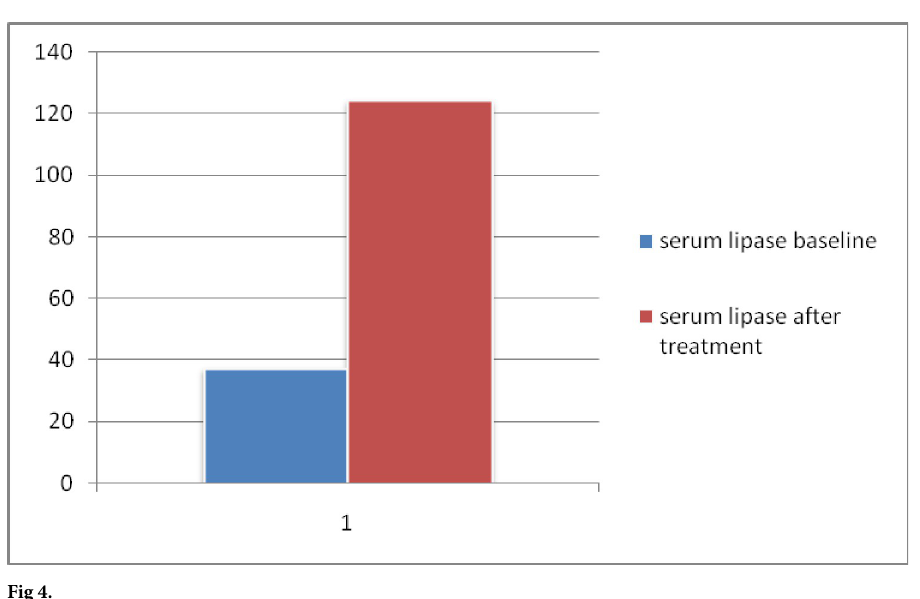
Fig 4. might be there were no exclusion criteria in which a factor that induce acute pancreatitis to that particular studies and due to different age group. However, our study excludes the factors that induces acute pancreatitis. A paired or dependent t-test was done and it showed a statisti- cally significant difference among serum pancreatic amylase and lipase before and after treat- ment with a p-value of < 0.001. There fore, serum amylase at TOC was 141.29 ± 39.07 U/L as compared to (51.33 ± 19.48 U/L) base line serum amylase (Fig 2 and Table 2). Similarly, the mean ± SD of serum lipase at TOC and before treatment was 123.9 ± 47.07 U/L and 37.1593 ± 20.81 U/L respectively. Thus, there was a statistically high significant elevation of lipase at test of cure as compared to the baseline level (p < 0.001) (Fig 4 and Table 4). Consequently, there was a statistically significant difference between serum amylase and lipase before and after treatment. In line to our study, the study conducted by Gasser et al. showed that 63(63%) study participants had elevated serum amylase at TOC, whereas 78 (78%) patients had elevated serum lipase level at TOC. Additionally, the study conducted earlier by Aronson et al. [23] revealed that, 86% of study subjects had elevated serum amylase. Aronson and his co-workers also notified that all of the participants had elevated serum lipase level. In line to this previous study, the result of our study confirmed the presence of elevated serum lipase level. The study conducted by Lyra et al., didn’t show the presence of significant association of hyperamylase- mia and hyperlipasemia with any socio-demographic studied variables [18]. It disagreed with our study, since in our study the correlation between serum amylase at TOC showed that there was a statistically significant and positive correlation with age (r = 0.2262 and p value < 0.05) and serum lipase at TOC to age (r = 0.2022 and p-value < 0.05). Our study also disagreed with the study conducted by Lyra et al., in which serum amylase and lipase at TOC were not corre- lated to factor variables [18]. The difference may be due to geographical and age distribution difference. On the contrary, there was no either positive or negative significant relation among height, weight and BMI of both serum amylase and lipase at TOC. As far as our search is con- cerned there was no similar studies done yet to correlate amylase and lipase from anthropo- metric measurements (Height, Weight and BMI).